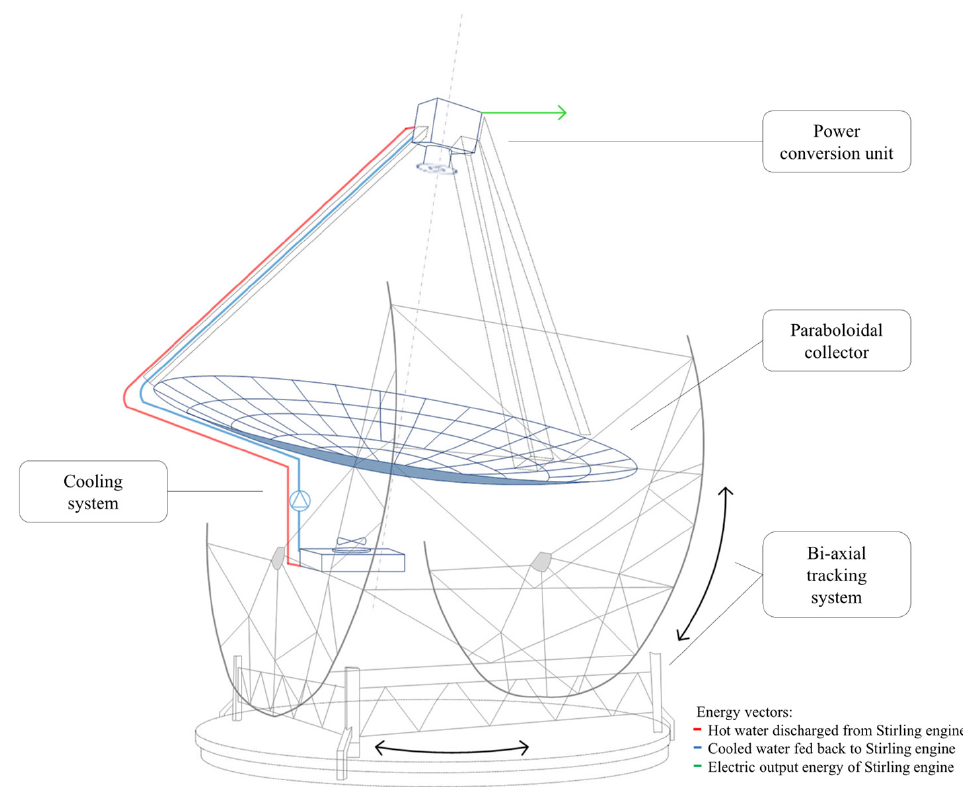
Figure 6. The layout of the dish–Stirling concentrator plant. Energy and Heat Balance